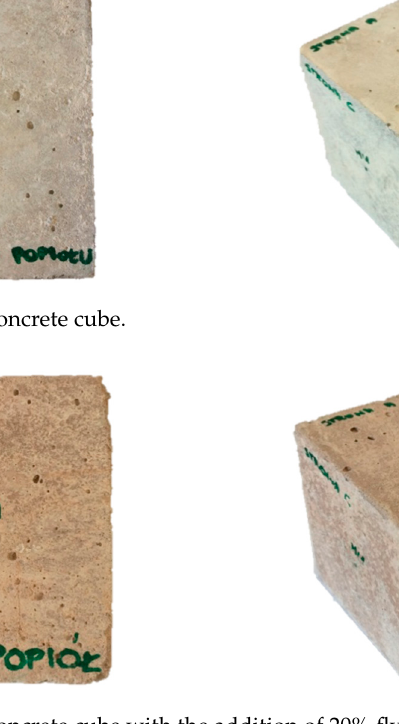
Figure 3. Ordinary concrete cube with the addition of 20% fly ash from sewage sludge.